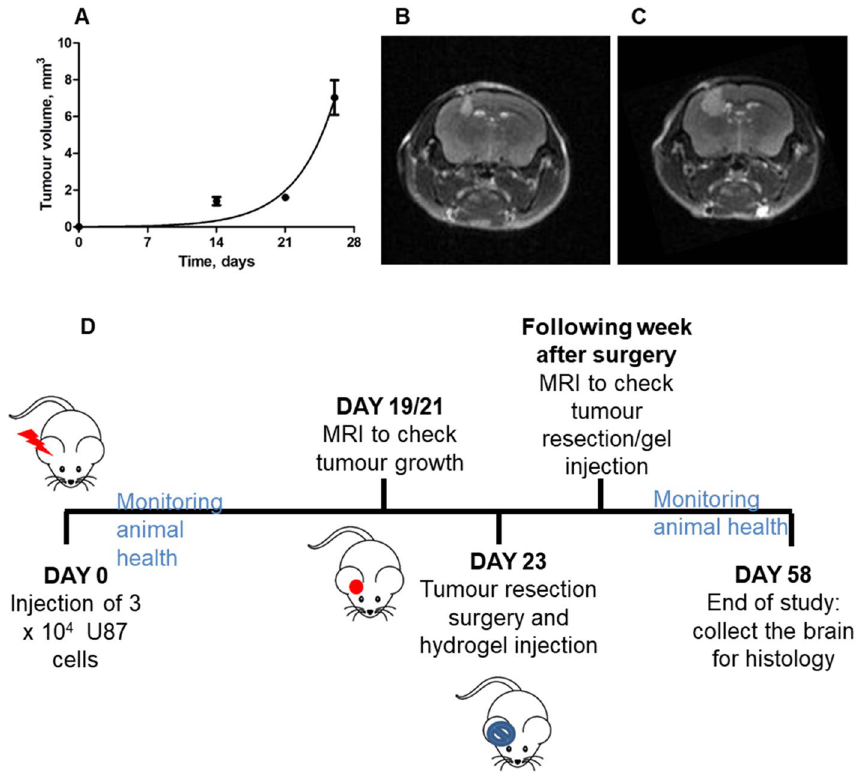
Figure 12. Tumour growth kinetics were monitored by Magnetic Resonance Imaging (n = 5). ( A ) Tumour growth curve fitted with an exponential growth model. ( B ) MRI image of tumour at day 21. ( C ) MRI image of tumour at day 26 after U-87 cell injection. ( D ) Schematic of in vivo